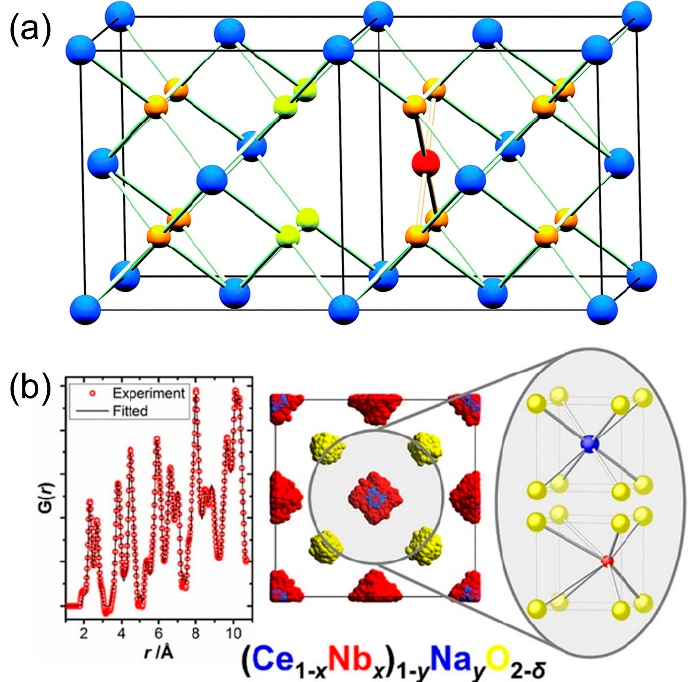
Figure 10. Local environment of ( a ) Pd 2+ and ( b ) Nb 5+ in substituted ceria materials prepared by hydrothermal synthesis. In ( a ), cerium is represented by the blue spheres, Pd by the red and the oxide anions by orange or yellow, with the oxide anions being adjacent to a vacant Ce site caused by the square planar preference of Pd 2+ [84]. In ( b ), the left panel shows the fitted pair distribution function used to derive the structural model shown on the right, where the colour scheme is indicated by the chemical formula [85]. ( a ) Reproduced from Hiley, C.I.; Fisher, J.M.; Thompsett, D.; Kashtiban, R.J.; Sloan, J.; Walton, R.I. Incorporation of square-planar Pd 2+ in fluorite CeO 2 : hydrothermal preparation, local structure, redox properties and stability. J. Mater. Chem. A 2015 , 3 , 13072–13079—Published by The Royal Society of Chemistry. ( b ) Reprinted with permission from Hiley, C.I.; Playford, H.Y.;